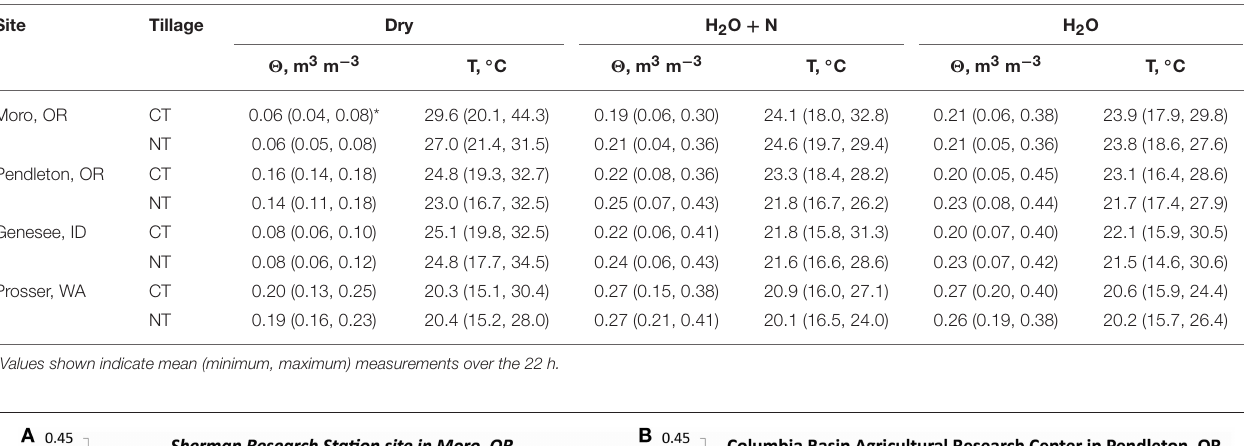
TABLE 2 | Soil temperature and moisture (20-cm depth) at no-tillage and conventional tillage winter wheat sites across inland Pacific Northwest for treatments without water additions, with water plus N added, and with water only added.